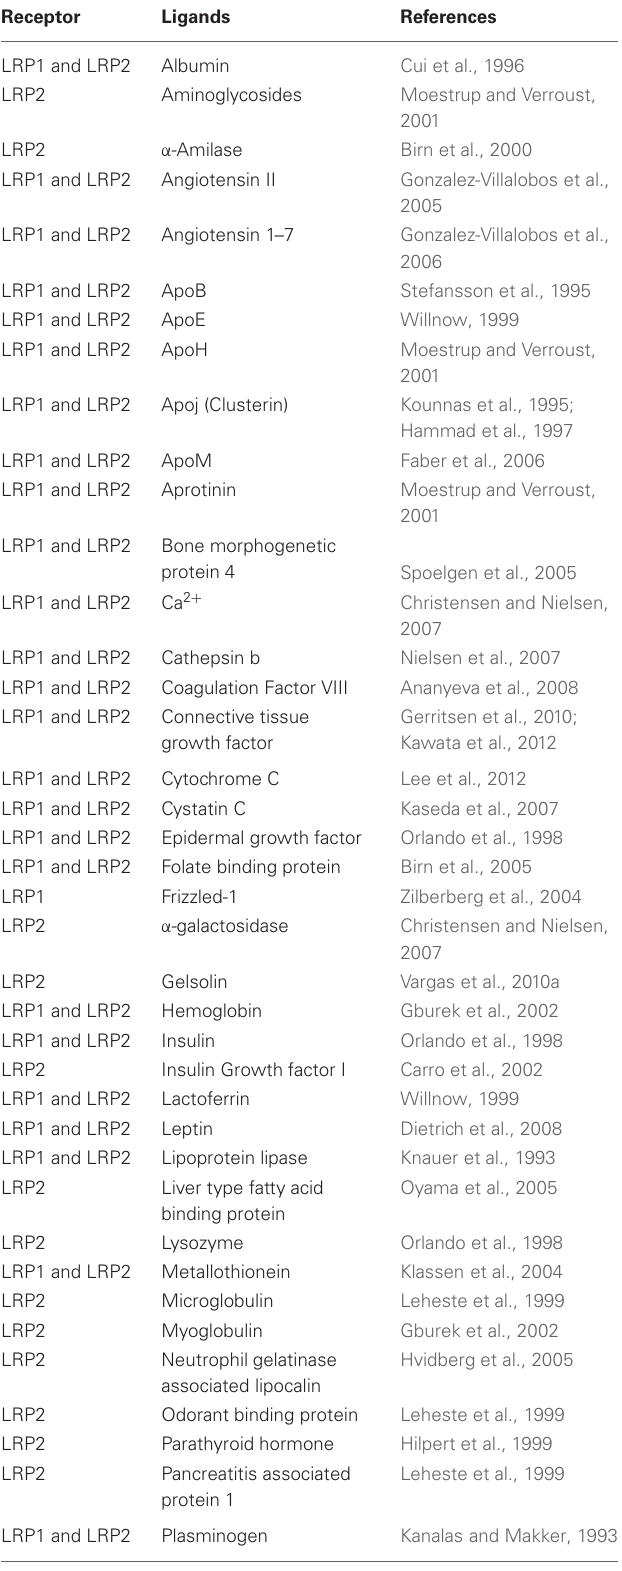
Table 1 | Ligands of LRP1 and